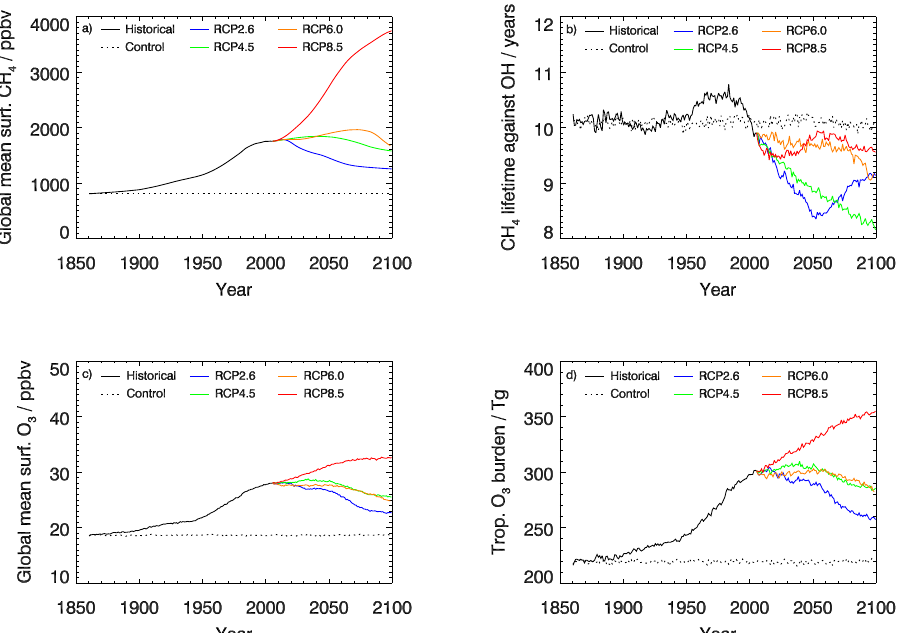
Fig. 30. Time series of (a) global mean surface CH 4 concentration, (b) CH 4 lifetime against OH, (c) global mean surface O 3 concentration, and (d) tropospheric O 3 burden in the HadGEM2-ES simulations carried out for CMIP5. Simulations include a pre-industrial control, an historical simulation, and 4 future simulations using RCP2.6, RCP4.5, RCP6.0, and RCP8.5.